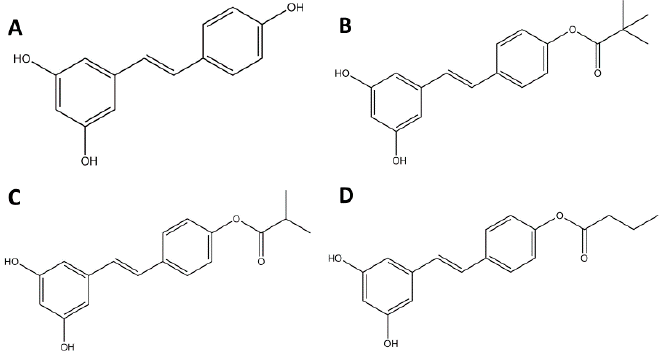
Figure 1. Structure of ( A ) trans -resveratrol, ( B ) 4 ′ -Pivalate trans -resveratrol, ( C ) 4 ′ -Isobutyrate trans -resveratrol, and ( D ) 4 ′ -Butyrate trans -resveratrol.